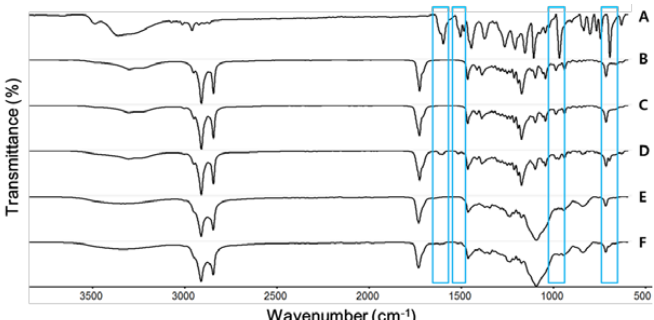
Figure 4. FT-IR spectra of ( A ) PR only; ( B ) GMS; ( C ) lipid melt; ( D ) PR-lipid melt; ( E ) freeze-dried blank-NLCs; ( F ) freeze-dried PR-NLCs.